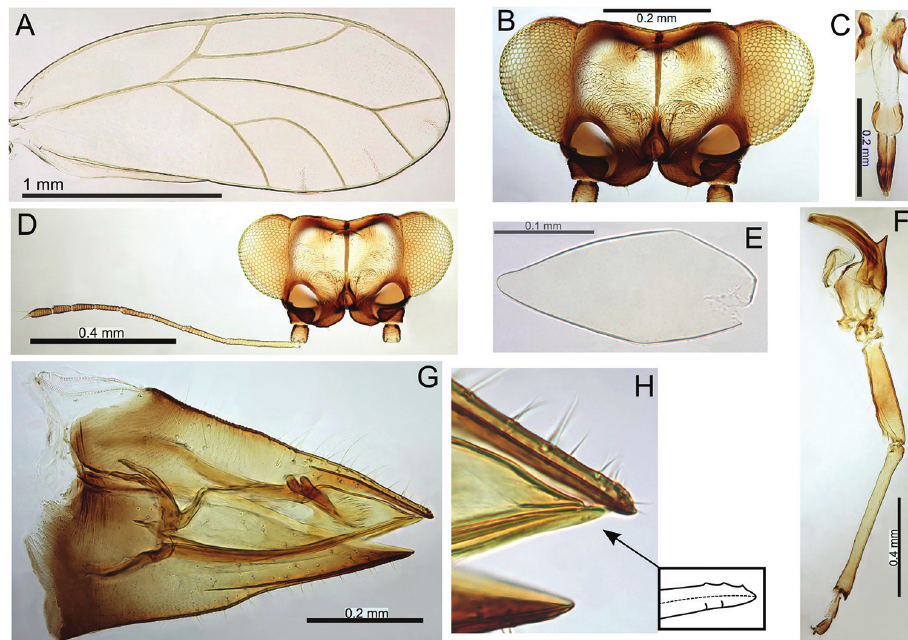
Figure 28. Pariaconus elegans sp. n. (female) A fore wing B head C proboscis D head and antenna E egg F hind leg G female terminalia H ovipositor (serrations indicated). Pariaconus gagneae Percy, sp. n.